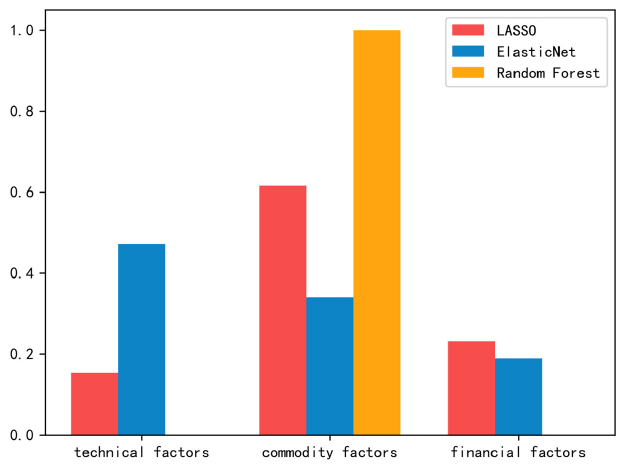
Figure 3. Factor selection results, by sector. Table 6. Description of the most important selected factors, using LASSO.